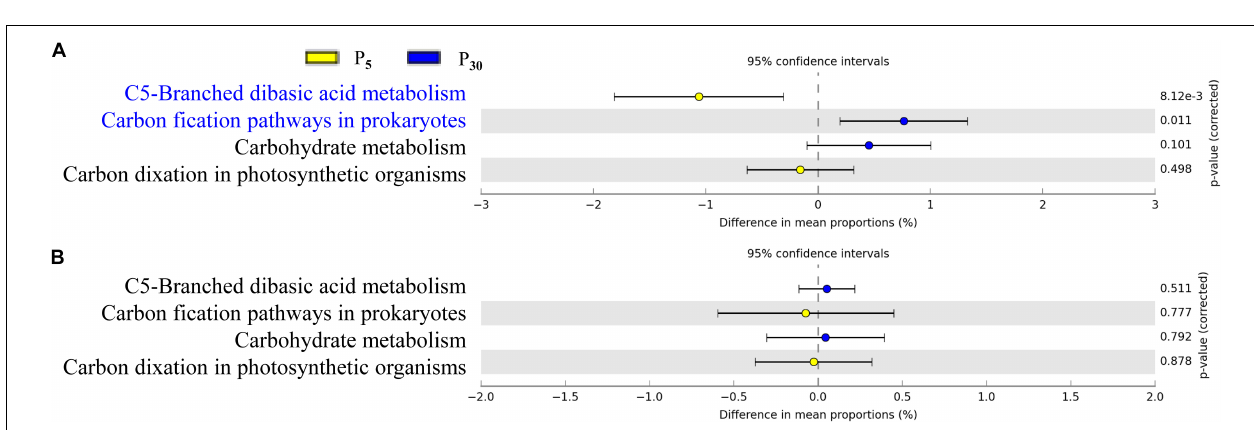
FIGURE 6 | Statistical comparison (Student’s t -test) between the predicted functions in rhizoplane bacterial OTUs of (A) maize and (B) clover grown at P 5 vs. P 30 . The OTUs relevant to carbon metabolism were based on the KEGG level 3 database using the Benjamini–Hochberg P -value correction ( P <